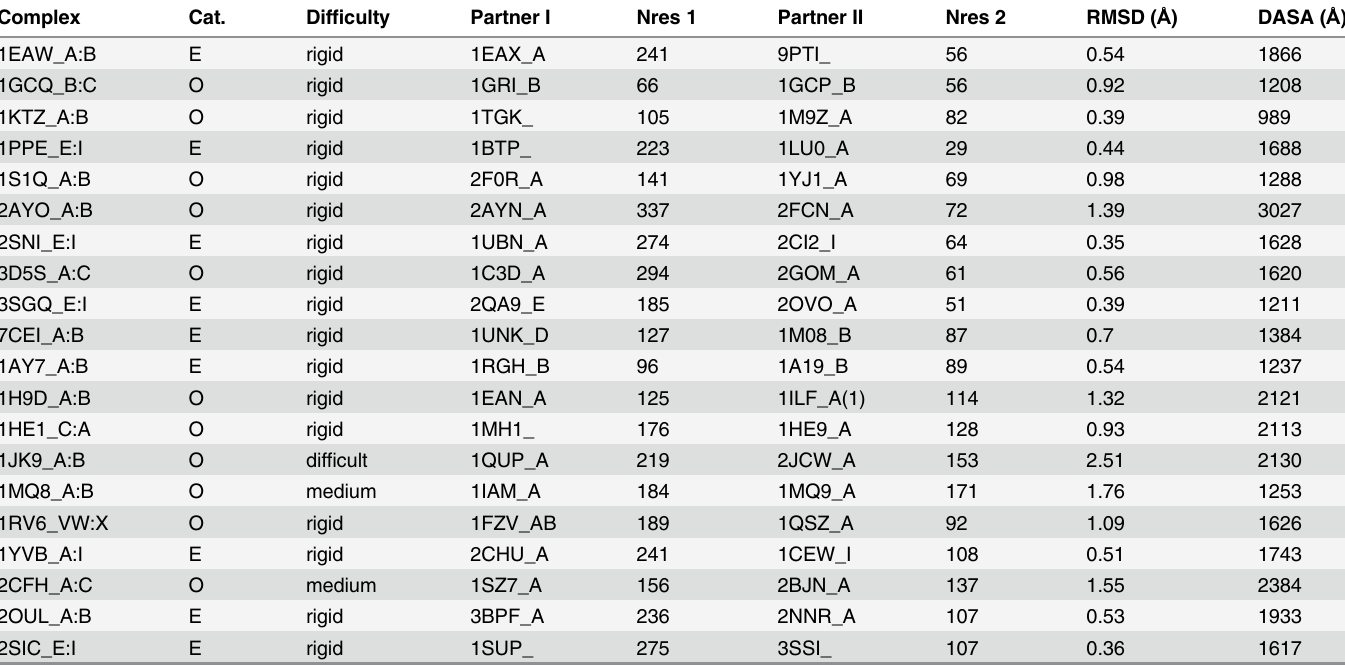
Table 1. Test complex structures and partner